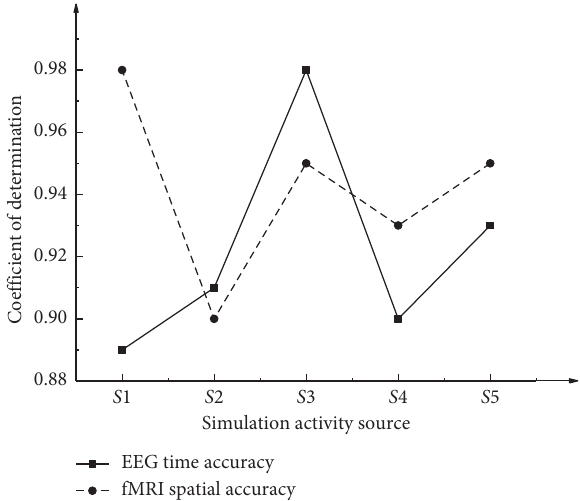
Figure 8: Simulation analysis results of EEG temporal registration accuracy and fMRI spatial registration